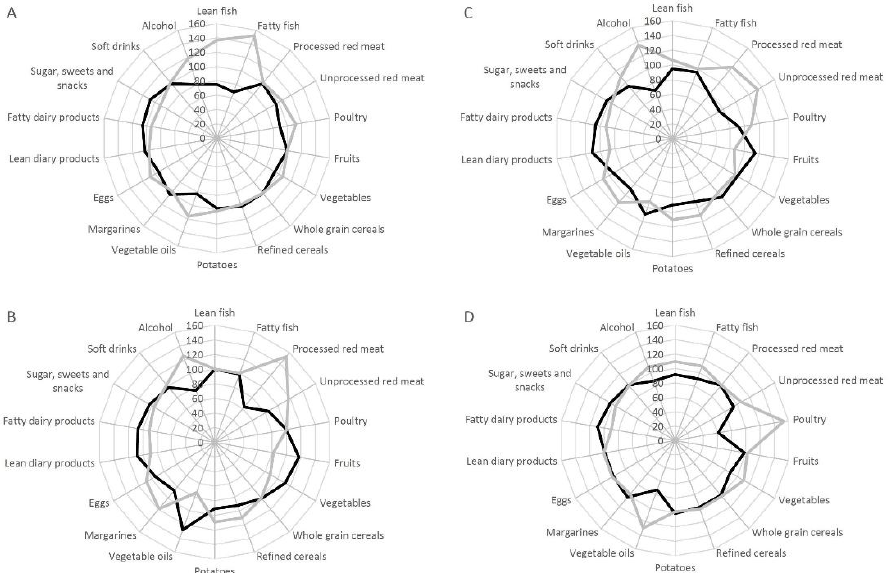
Figure 2. Radar charts illustrating the difference in intake of food groups and beverages according to lowest and highest intakes of ( A ) fish, ( B ) processed red meat, ( C ) unprocessed red meat, and ( D ) poultry. Highest intake is illustrated with a black line and lowest intake is illustrated with a grey line.